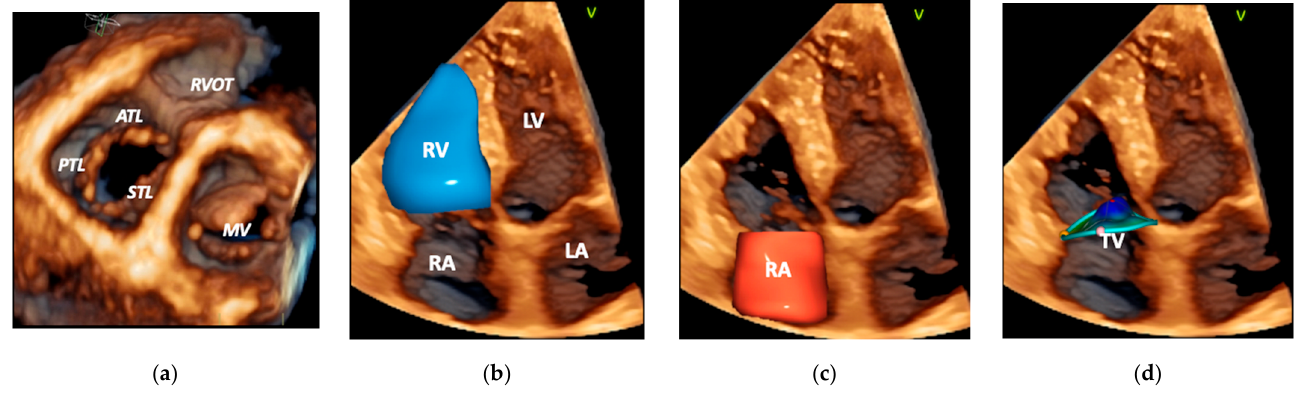
Figure 3. Utility of transthoracic 3DE to assess patients with tricuspid regurgitation. ( a ) Tricuspid valve functional anatomy. ( b ) Right ventricular volume and ejection fraction. ( c ) Right atrial size and function. ( d ) Tricuspid annulus geometry and valve tenting volume and height. Abbreviations: 3DE, three-dimensional echocardiography; ATL, anterior tricuspid leaflet; LA, left atrium; LV, left ventricle; MV, mitral valve; PTL, posterior tricuspid leaflet; RA, right atrium; RV, right ventricle; RVOT, right ventricular outflow tract; STL, septal tricuspid leaflet; TV, tricuspid valve.